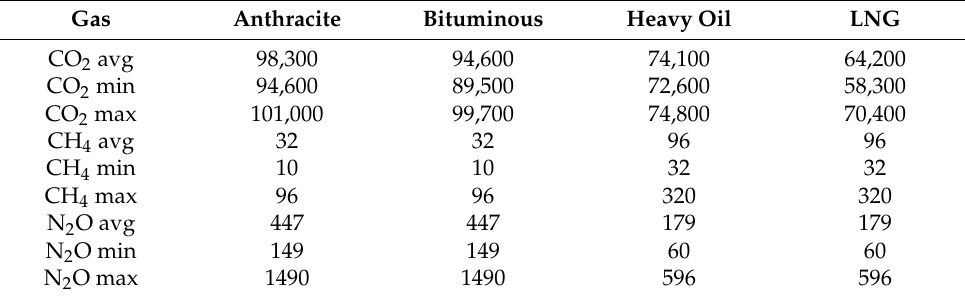
Table 1. Fuel emission factor (kg CO 2 -eq/kg